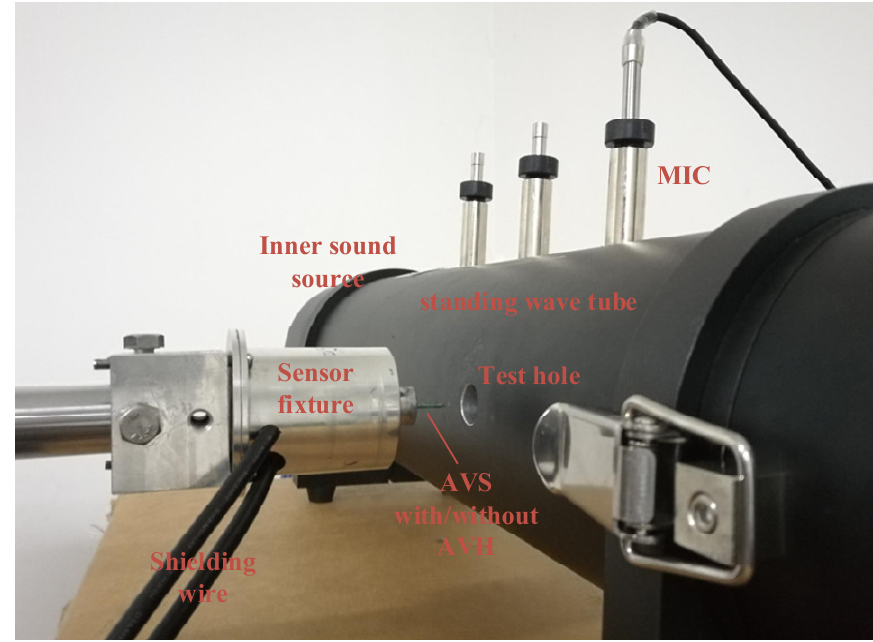
Figure 11. Photograph of the SWT used for the acoustic horns amplification factor test.